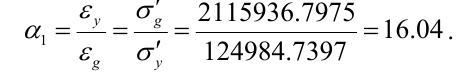
Fig. 7 Axial stain curve of fiber-optical.